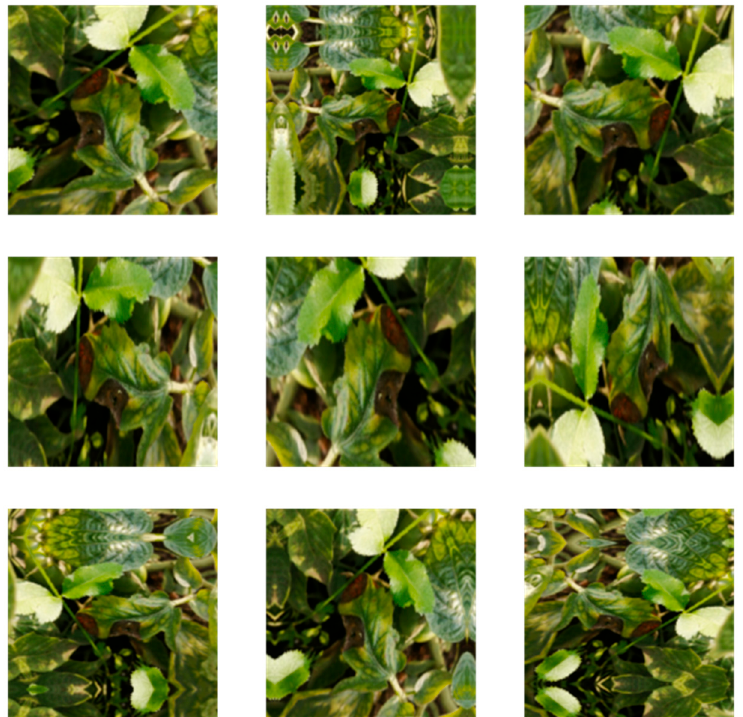
Figure 3. Data augmentation for field-captured images of tomato leaf diseases. The image appears in different positions using flipping, rotation, and zooming together with randomly chosen values.